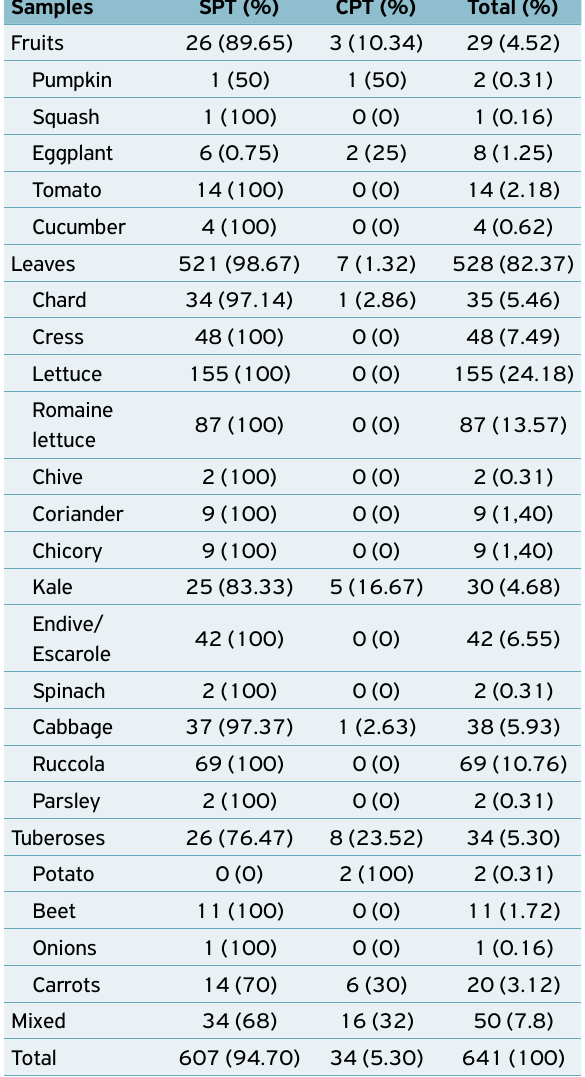
Table 1. A percentage of SPT and CPT samples, and total percent - age of salads analyzed at SOAP during the 2010‑2014 period.